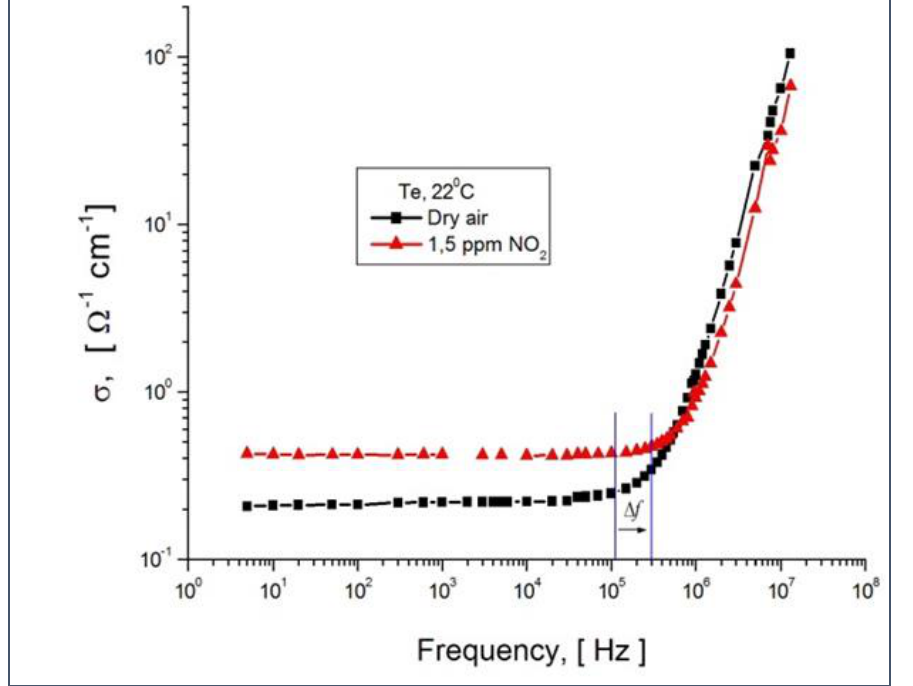
Figure 6. The conductivity spectra of amorphous Te films in different gaseous environments, at room